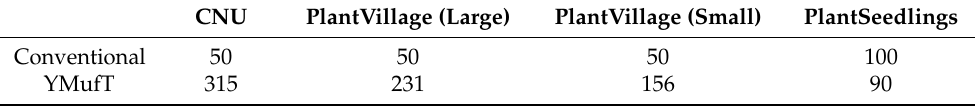
Table 4. Number of times the model was validated in the conventional and YMufT strategies. CNU PlantVillage (Large) PlantVillage (Small) PlantSeedlings Conventional